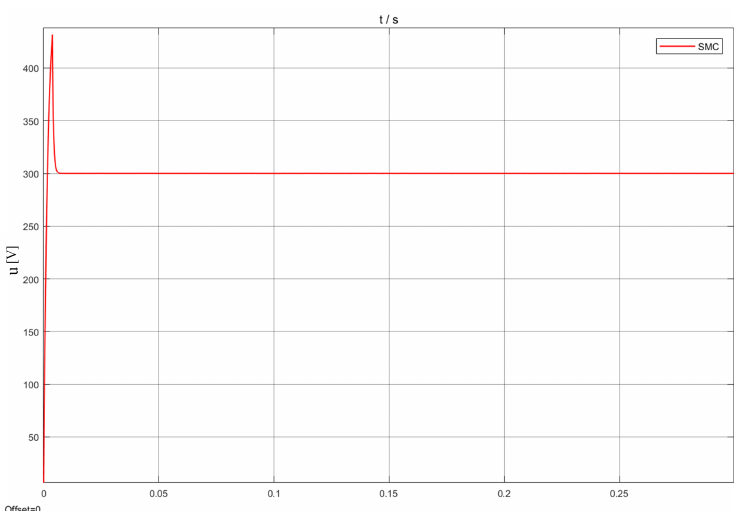
Figure 11. The output voltage waveform under the input voltage is 400